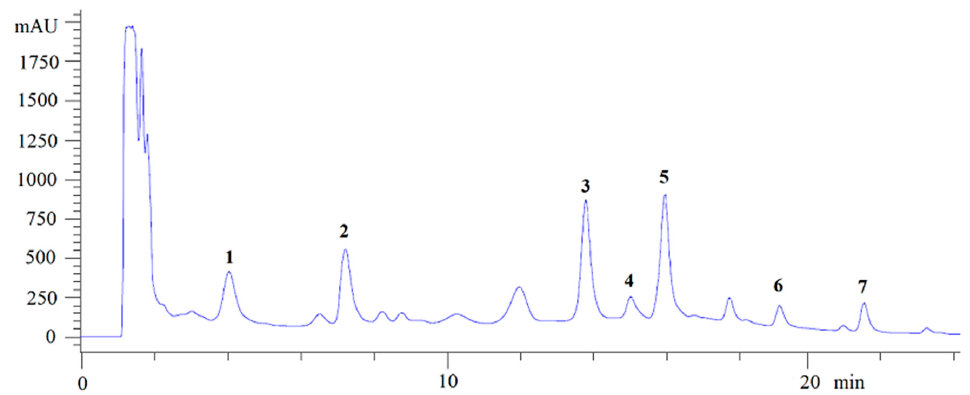
Figure 1. Chromatogram of the ethanolic extract with molecules associated to the peaks.